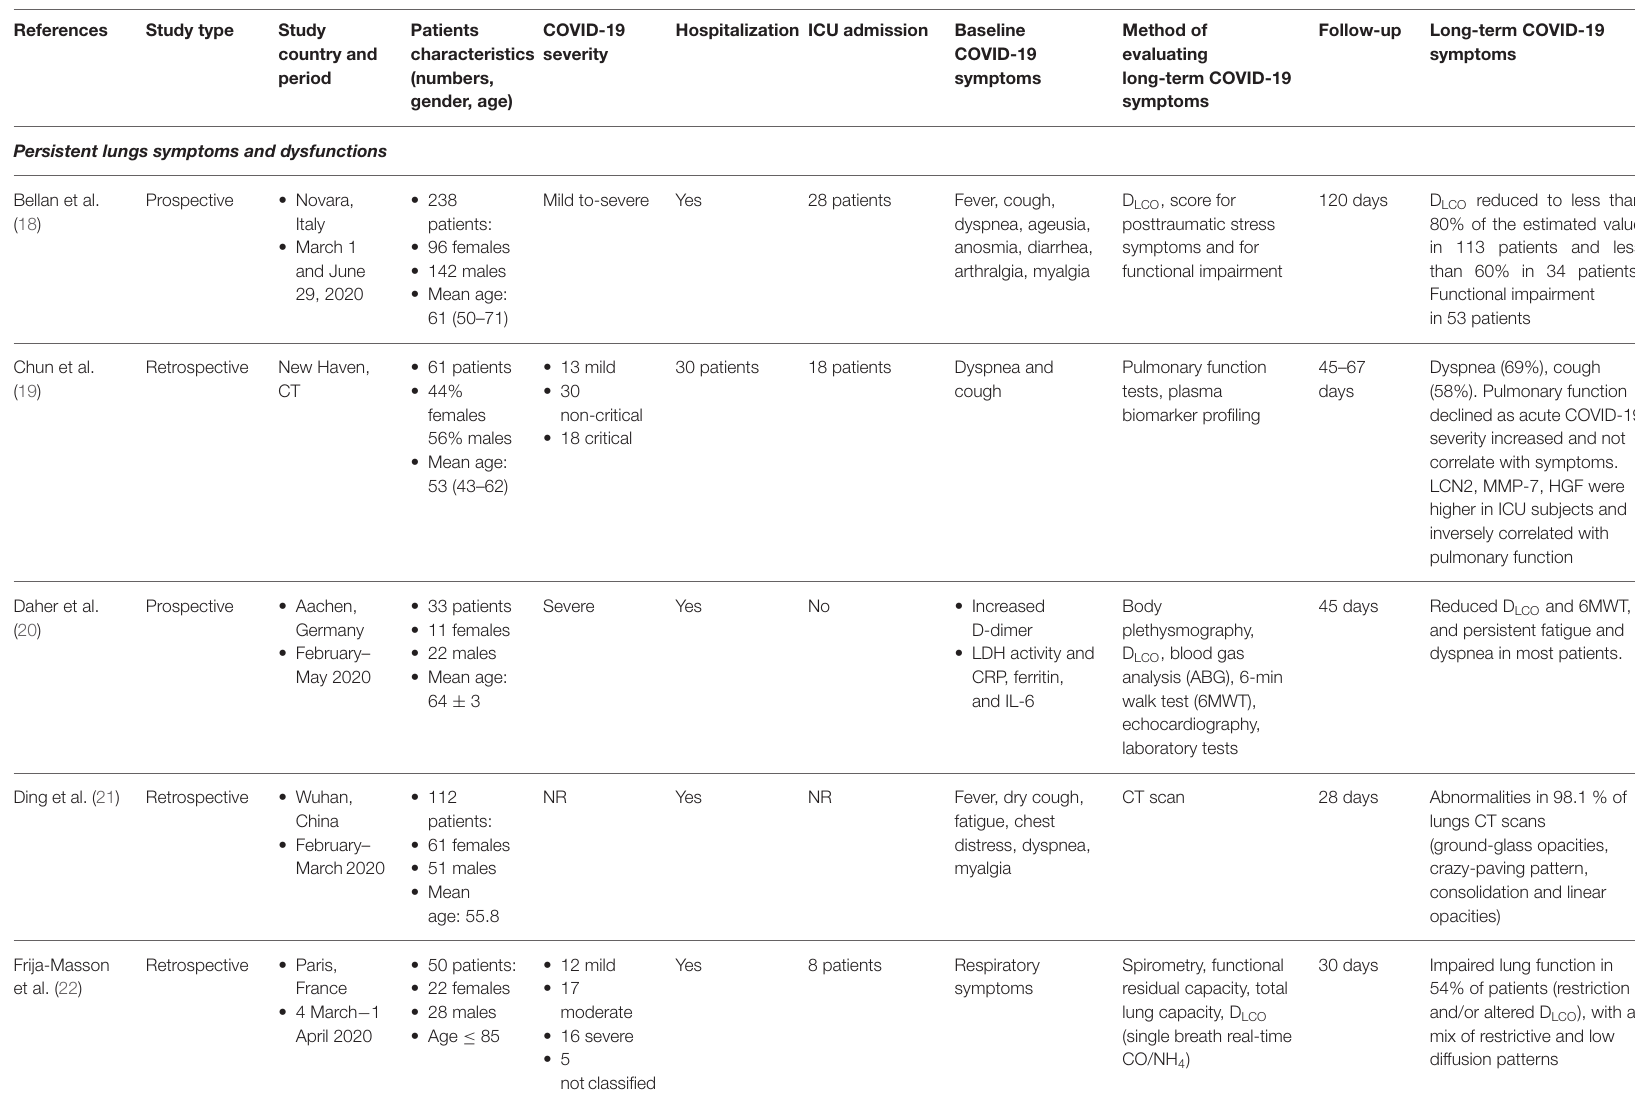
TABLE 1 | Cohort (perspective and retrospective), cross-sectional, case-report, cases-series and case-control studies on long-term lungs symptoms, long-term neurological and olfactory symptoms, and widespread long-term